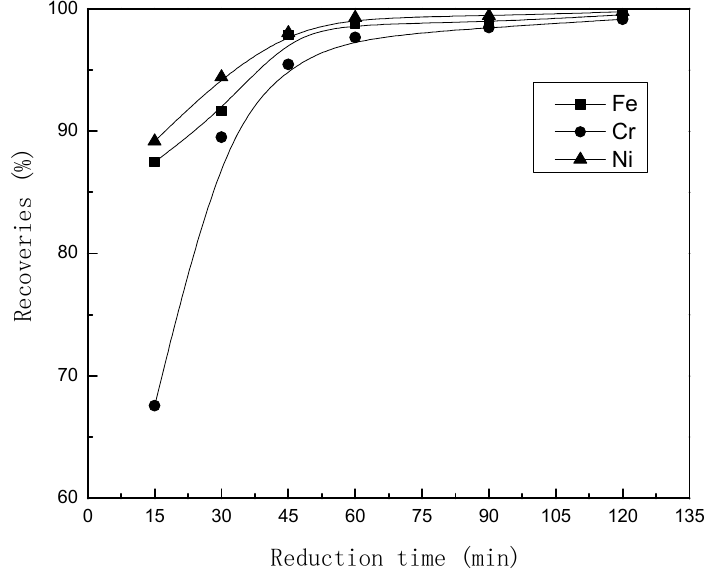
Figure 5. Effect of reduction time on metals recoveries.